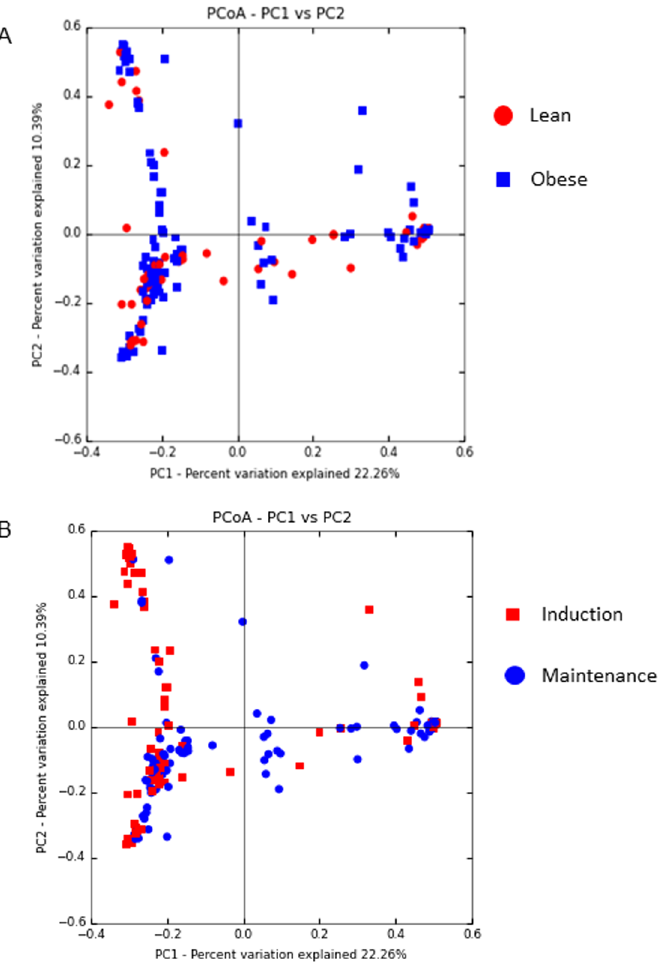
Fig 2. PCoA plots of distances between pig urogenital bacterial communities. Variancesexplained are shown on the axes. Plots includeall vaginalswab and cervical flush samples taken of each pig throughout the course of the study. (A) Comparisonof lean and obeseanimalsthroughoutthe wholestudy. (B) Comparison of all samples from both obeseand lean animalsduringthe inductionversus the maintenance phase of the diet. Each point representsone sample. The color key providesinformationto determine the influenceof features on spatial placement.